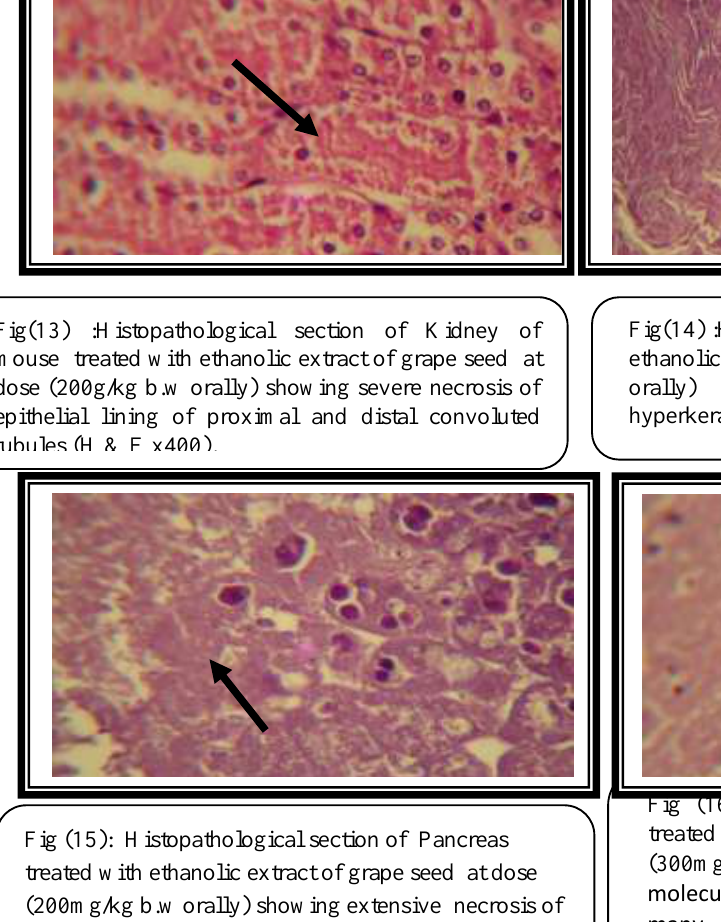
Fig (16): Histopathological section of Cerebllum treated with ethanolic extract of grape seed at dose (300mg/kg b.w orally) showing edema between molecular and granular layer with degeneration of many purkinji and complete dissolution of the others (H&E x400).